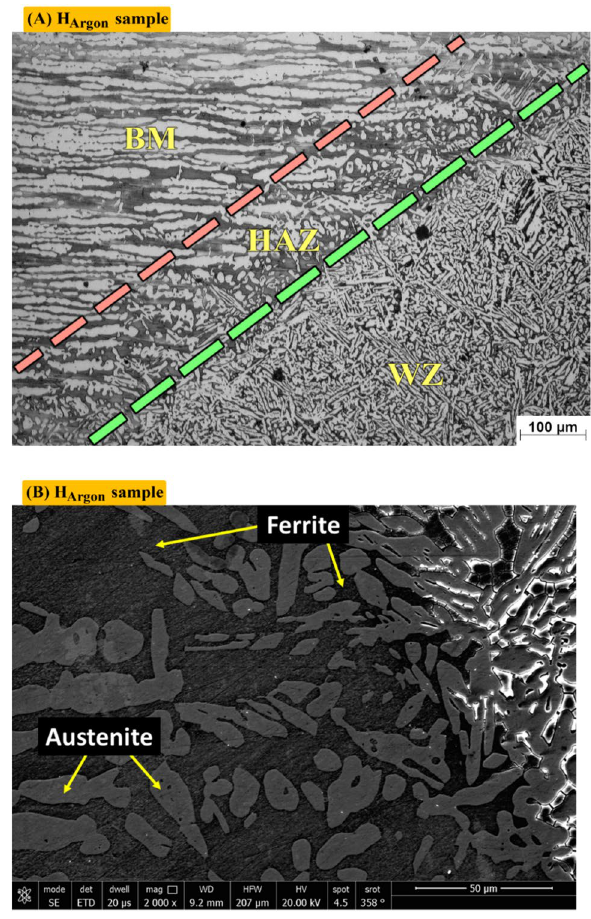
Figure 12. Optical and SEM micrographs of Heat effected zone of sample (H Argon ) protected with Argon gas during PWHT